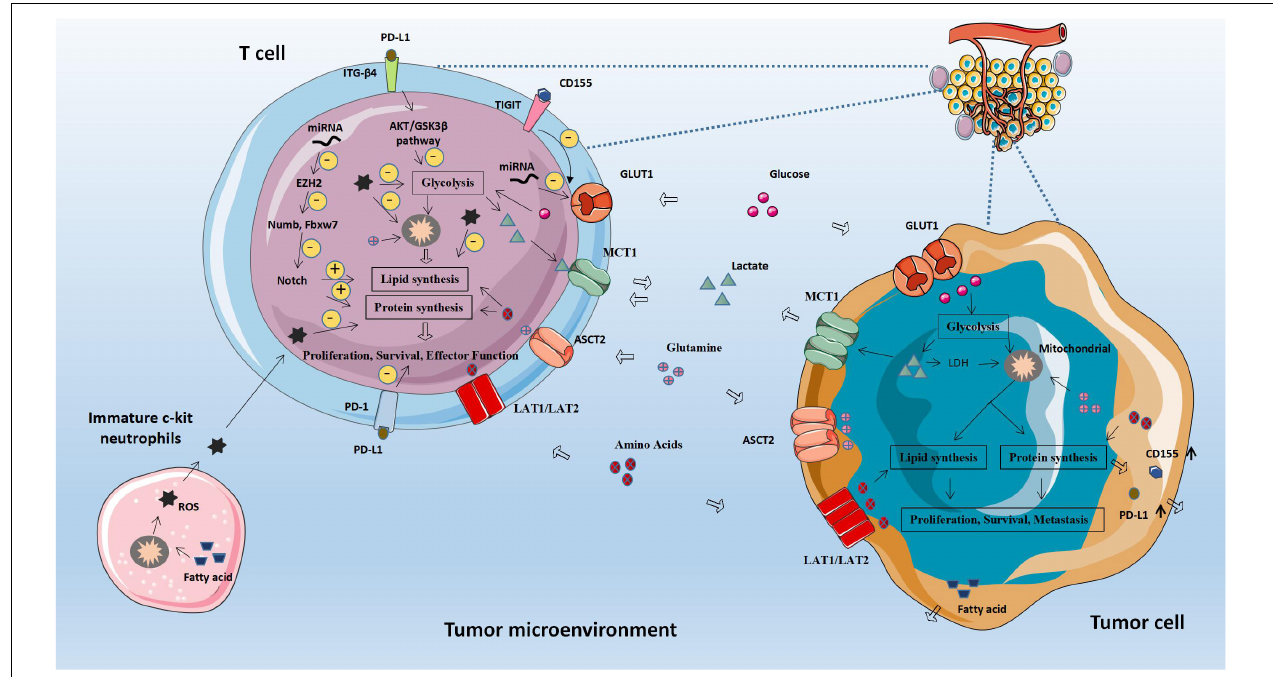
FIGURE 2 | Abnormal fatty acid metabolism and tumors. The abnormal metabolism of lipids and lipid-related molecules in tumor cells will affect the metabolic level of immune cells, leading to immune cell dysfunction, achieving immune evasion and weakening anti-tumor immunity. CPT1A, Carnitine palmitoyltransferase 1A; ACC1, Acetyl-CoA carboxylase 1; ASM, Acid sphingomyelinase; MCP-1, Monocyte chemoattractant protein 1; FASN, Fatty acid